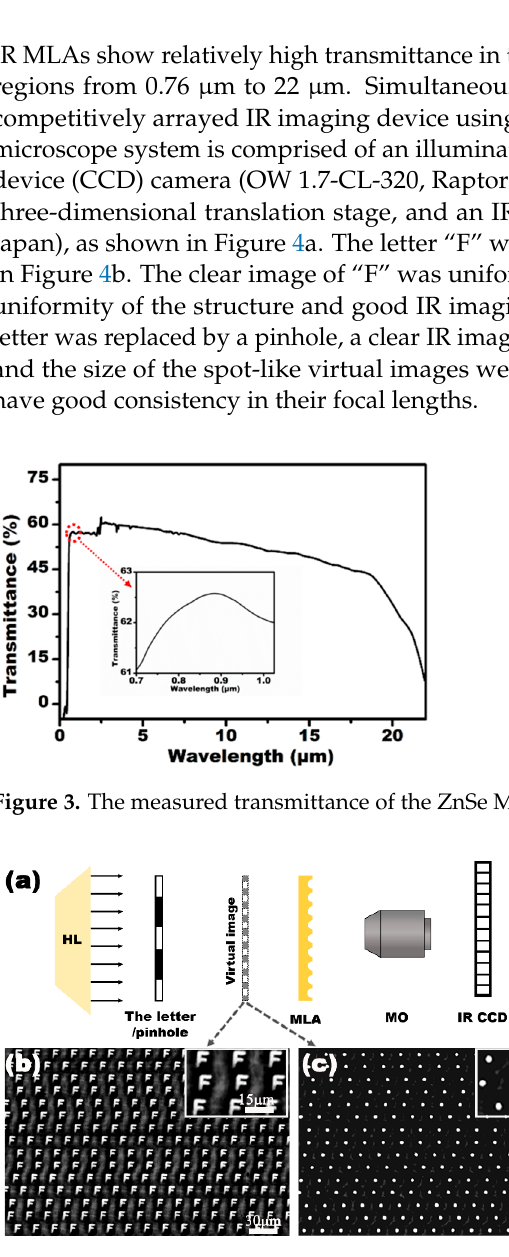
Figure 4. The IR imaging performance of the quasi-periodic MLA. ( a ) The simplified setups of the IR optical system for measurement, HL is the halogen lamp, MLA is the sample device, and MO is the microscope objective; IR CCD is the imaging sensor responsing in the IR region; ( b ) the false images of the letter “F”, using the laser power of 5 mW; ( c ) the false bright focal point of the fabricated MLA. The scanning speed and the laser power are important parameters in this experiment.